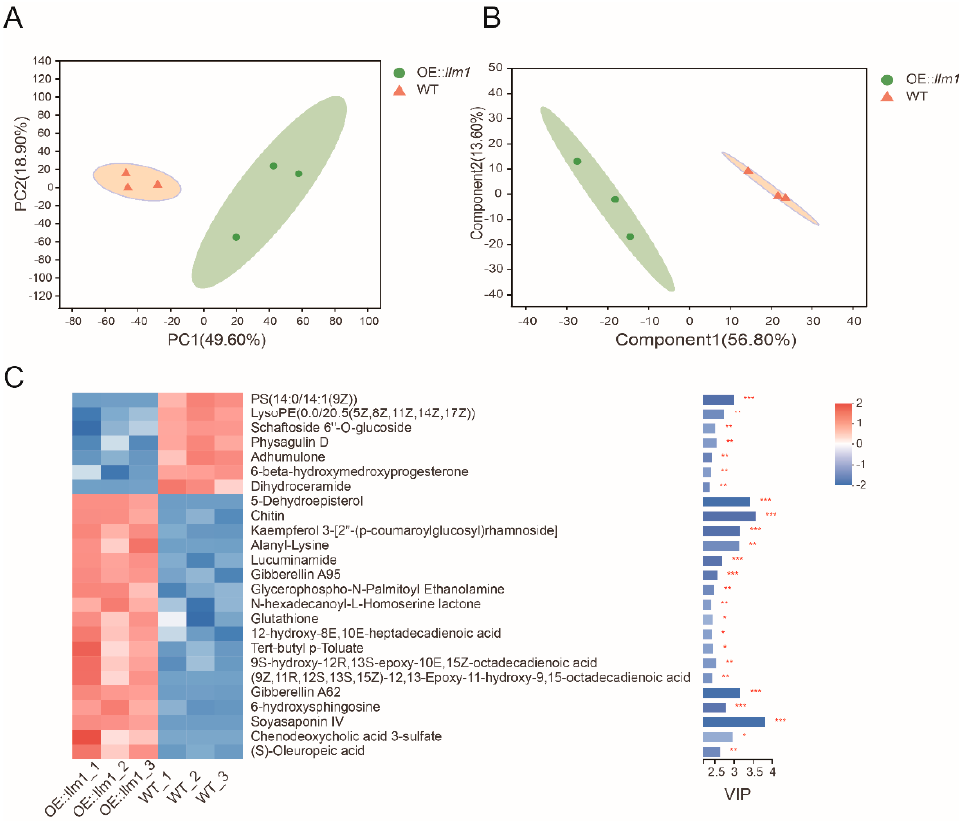
Figure 4. The metabolites in the OE:: llm1 group compared to those in the WT group. ( A ) PCA score plot of metabolite profiles from the OE:: llm1 group and WT group. ( B ) PLS-DA score plot of metabolite profiles from the OE:: llm1 group and WT group. ( C ) Heat map of VIP score calculated by PLS-DA. The color represents the relative abundance of the metabolites in the samples. On the right is the VIP bar graph of metabolites. The length of the bar represents the contribution value of the metabolite to the difference between the groups (* p < 0.05, ** p < 0.01, *** p < 0.001). Based on the PLS-DA model, a total of 80 different metabolites (VIP > 1, p < 0.05 and FC ≥ 1.5 or FC ≤ 0.67) were selected (Supplementary Table S2). The HMDB database clas-